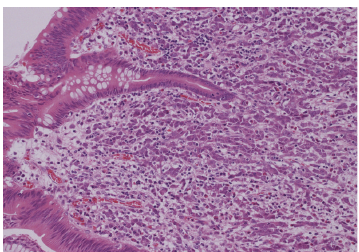
Figure3:Submucosashowsdiffuseinfiltrationbysmalltomoderate sized malignant epithelial cells with prominent trabecular/Indian filing pattern and vesicular nucleolated nuclei. There is no evidence of glandular formation (H&E stain, magnification ×